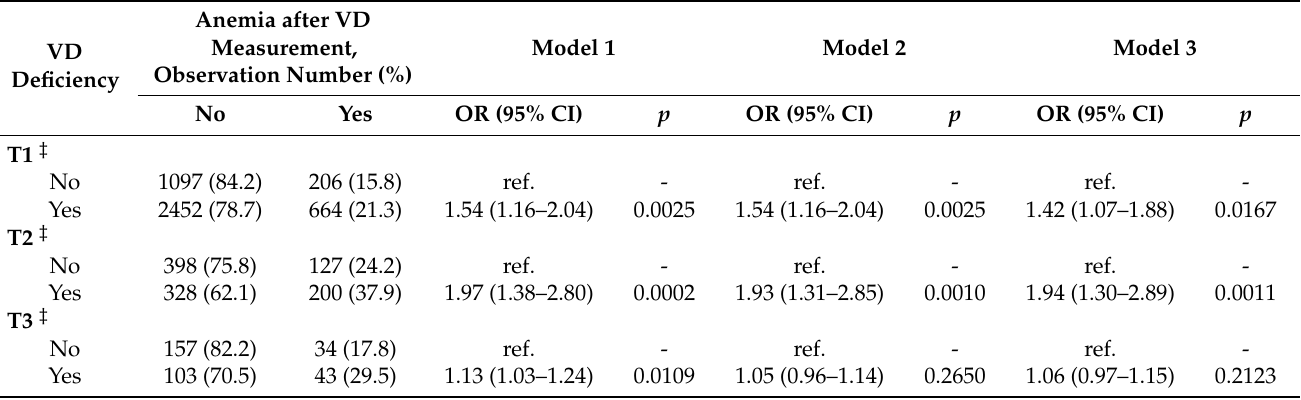
Table 4. The association * between VD deficiency in different trimesters and anemia during pregnancy after the corresponding 25(OH)D measurement.